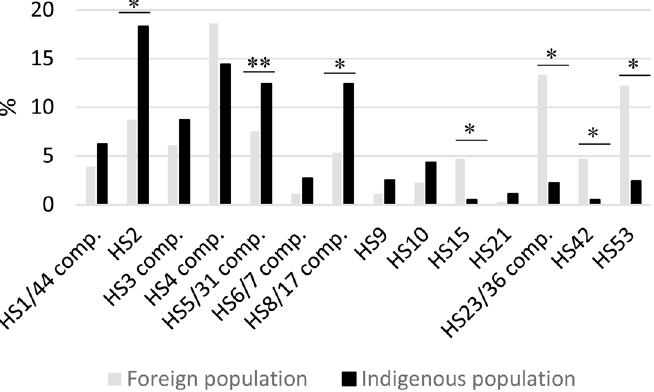
Fig 4. Comparison of the capsule type distribution between indigenous Southeast/South Asia population and foreign population. ( * ) statistically significant (p < 0.01). ( ** ) statistically significant (p <